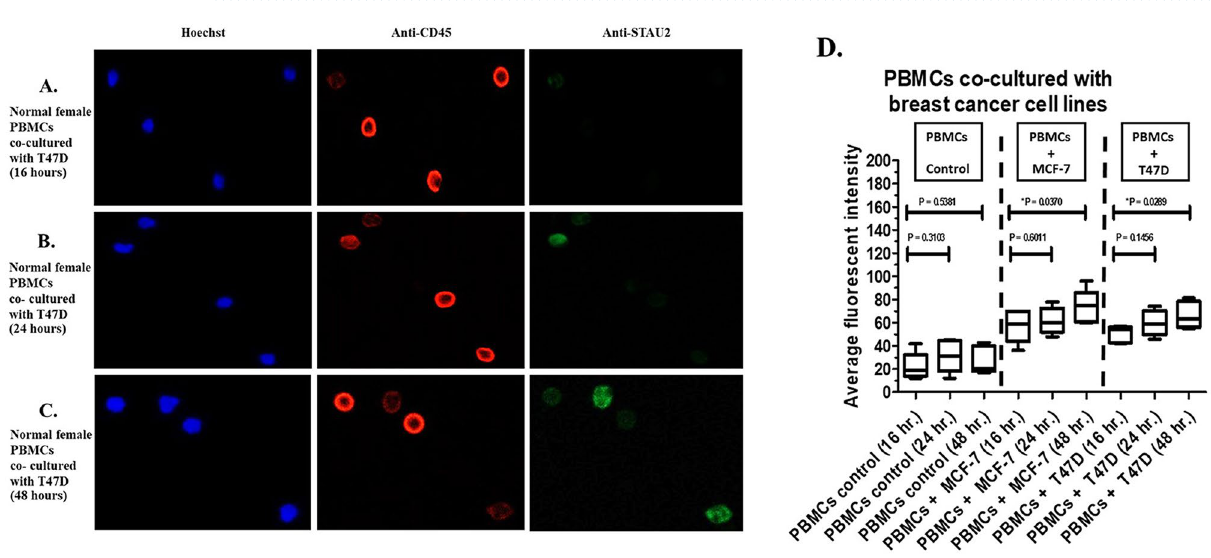
Figure 2. Fluorescent signals were increased in PBMCs cocultured with breast cancer cells. ( A ) The fluorescent signal from PBMCs cocultured with T47D cells at 16 h. ( B ) The fluorescent signal from PBMCs cocultured with T47D cells at 24 h. ( C ) The fluorescent signal from PBMCs cocultured with T47D cells at 48 h. ( D ) An increase in the intensity of the anti-STAU2 fluorescent signal was observed in PBMCs cocultured with both MCF-7 ( p = 0.0370) and T47D ( p = 0.0289) cells compared with control PBMCs. The intensity detection was operated by CellSens imaging software (Olympus Co., Ltd.,